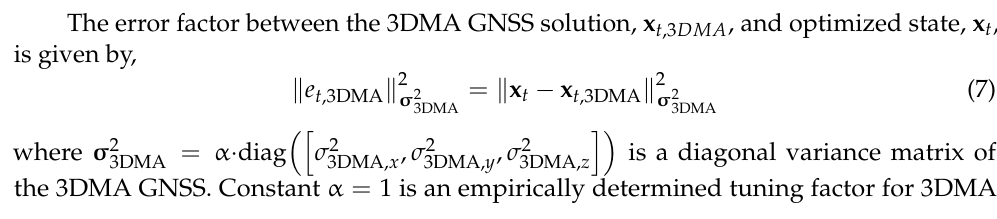
Figure 5. Structure of the proposed loosely-coupled 3DMA GNSS and velocity via